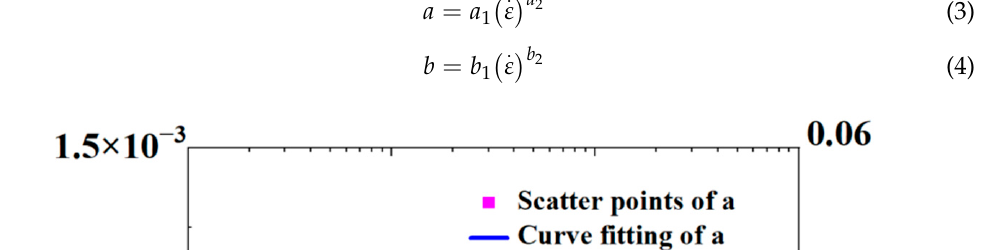
Table 2. Fitting parameters of equations.